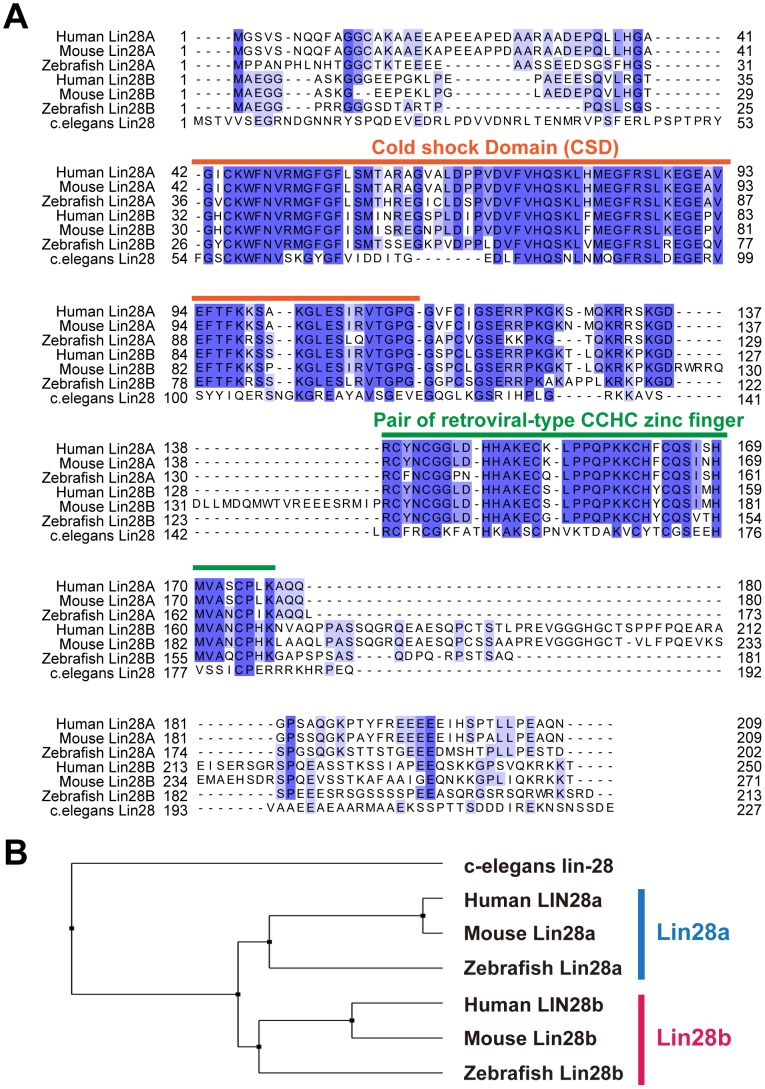
Cloning and characterization of zebrafish Lin-28a and Lin-28b.A. Deduced amino acid sequences of zebrafish Lin-28a and Lin-28b aligned against human, mouse and c.elegans Lin28 homologs. Blue boxes represent identical and similar amino acids. The characteristic Lin28 structure including cold-shock domain and two CCHC-Zn finger domains was highly conserved in zebrafish Lin-28a and Lin-28b. B. The phylogeny of the Lin28 family based on the alignment of full length of amino acid sequence. The branch length (X axis) in the rectangular cladogram represent the distances among those sequences calculated using BLOSUM62 substitution matrix.